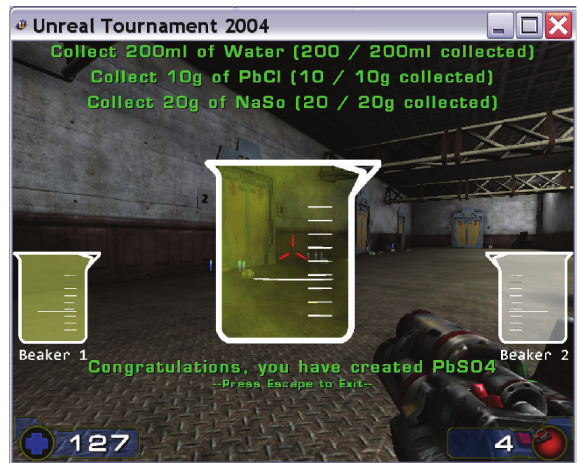
Figure 3: ChemLab FPS game final screen.